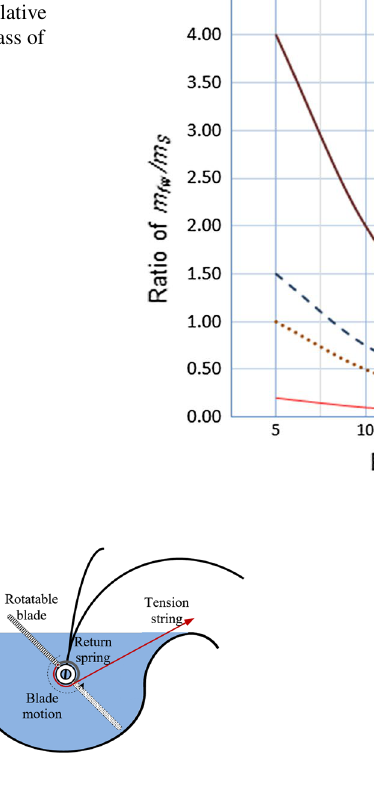
Fig. 3 A schematic diagram of a proposed bowl-rotatable blade sys- tem